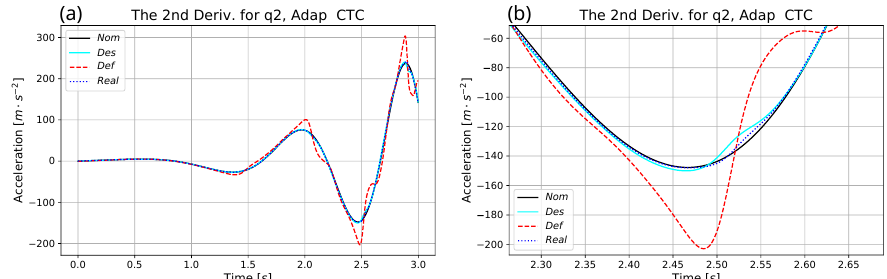
Figure 17. Second time derivatives for q 2 ( a ) and the zoomed-in excerpts ( b ) for the adaptive CTC controller using the identified parameters.